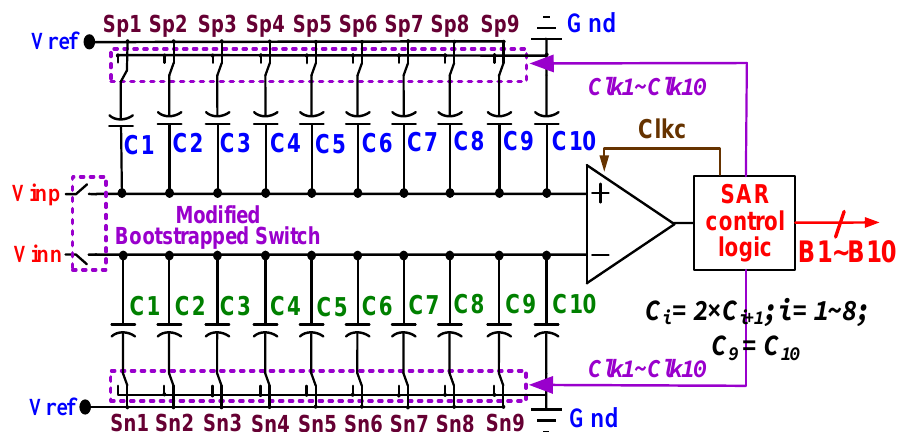
Figure 3. Adopted dual-ended SAR ADC with monotonic switching topology.